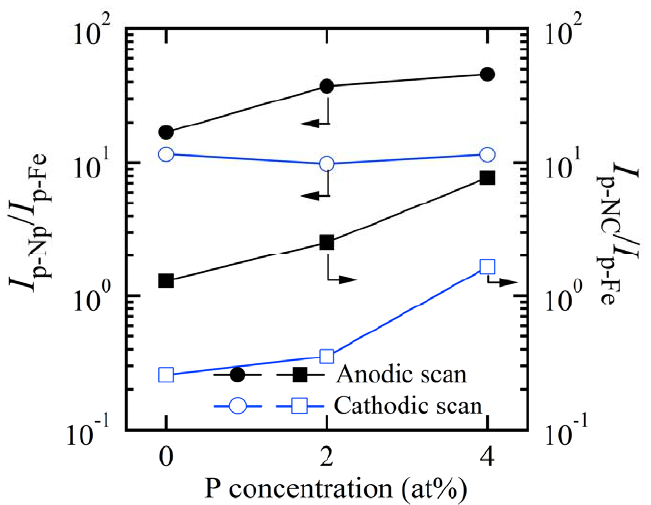
Figure 9. The increasing efficiency of Redox reaction of nanoporous and nanocrystalline Fe 85.2 B 14 Cu 0.8 , Fe 85.2 B 12 P 2 Cu 0.8 and Fe 85.2 B 10 P 4 Cu 0.8 electrodes with the P concentration normalized by the peak current density of Fe plate electrodes in 6 M KOH solution. I p-Np / I p-Fe : Ratio of the peak current density between nanoporous electrodes and Fe plate electrode; I p-NC / I p-Fe : Ratio of the peak